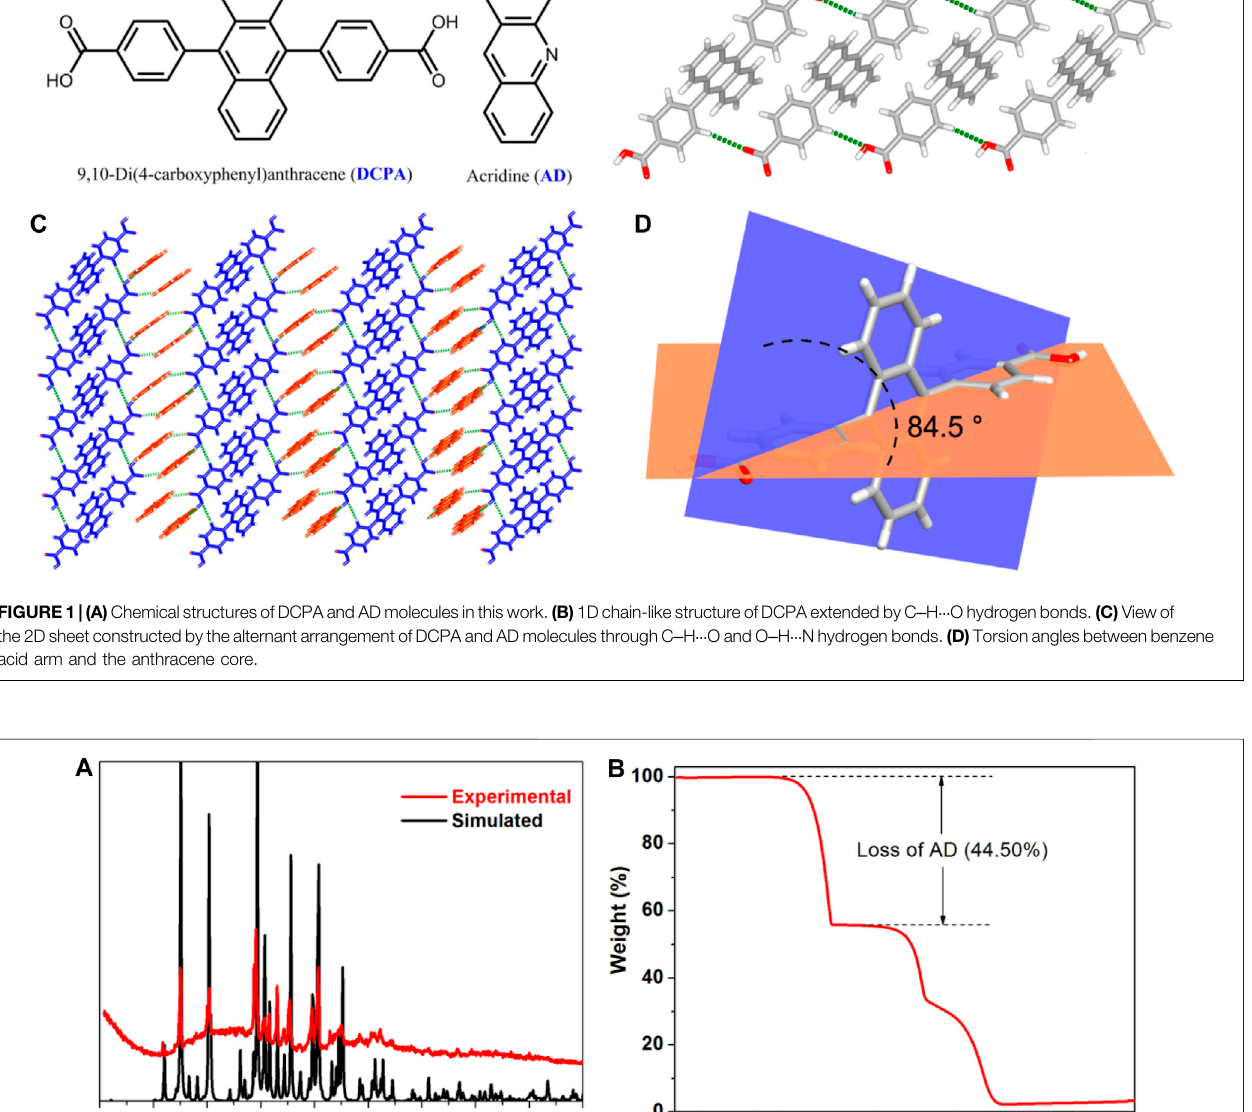
Frontiers in Chemistry |